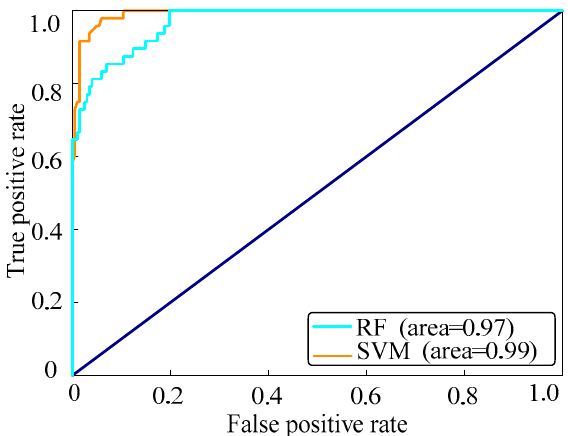
Figure 19. Performance comparison for di ff erent random forest (RF) and SVM.